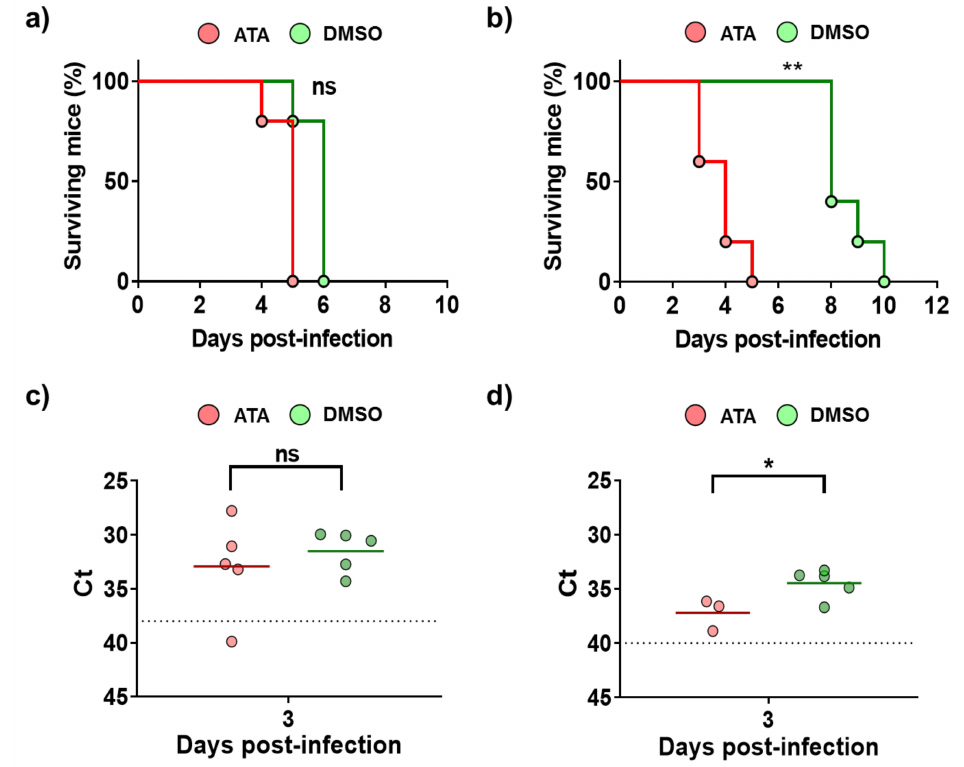
Figure 5. Analysis of ATA activity in mice. Groups of IFNAR ( − / − ) mice were treated with ATA or DMSO and challenged with a lethal dose of BTV-4 ( a , c ) or AHSV-4 ( b , d ). Treatments began 24 h before virus exposure and were administered i.p once daily for 8 days or until the mice died. ( a , b ) E ff ect of ATA on survival. Mortality of ATA- or DMSO-treated mice challenged with BTV-4 ( a ) or AHSV-4 ( b ) was evaluated. Log rank (Mantel–Cox) test was used to compare groups. ** p < 0.005 ns, not significant. ( c , d ) E ff ect of ATA on viral replication. Blood samples were collected on day 3 post-infection for subsequent analysis of viremia by real-time RT-qPCR. Horizontal lines indicate the means. Dotted lines indicate the threshold of a Ct of 38 for BTV-4 or 40 for AHSV-4, above which viremia is considered absent. * p < 0.05, using Student’s t